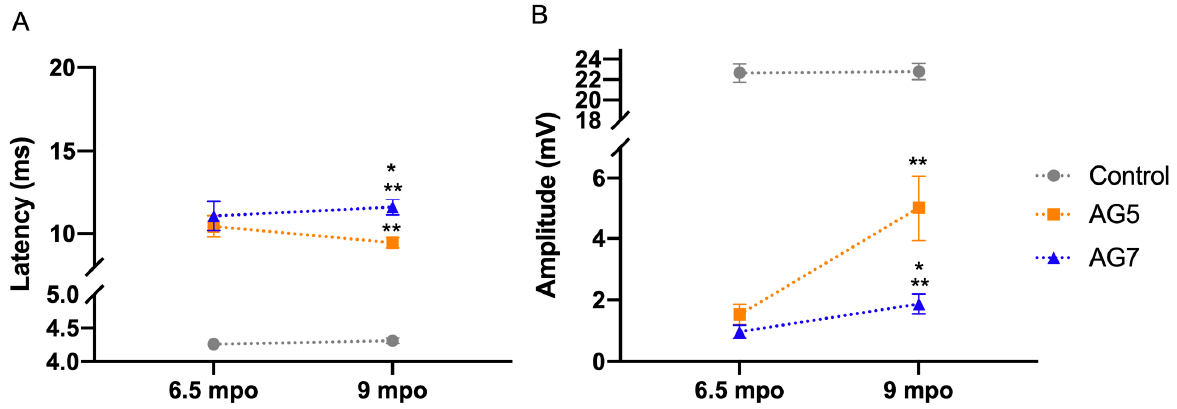
Figure 2. Plots of the latency ( A ) and the amplitude ( B ) of the TA CMAP evoked by stimulation of the sciatic nerve at the sciatic notch and recorded at 6.5 and 9 months (mpo) after surgical insertion of autografts of 5 and 7 cm length, AG5 and AG7, respectively, and compared with the measurements made in the control contralateral hindlimb. ( A ). Small and long latency CMAPs were recorded in 3 of the sheep of each experimental group at 6.5 mpo. ( B ). The CMAP amplitudes increased at 9 mpo, although they were much lower than in control muscles. Values are represented as mean ± SEM. * p < 0.05 AG7 vs. group AG5; ** p < 0.0001 AG5 and AG7 groups vs. Control.